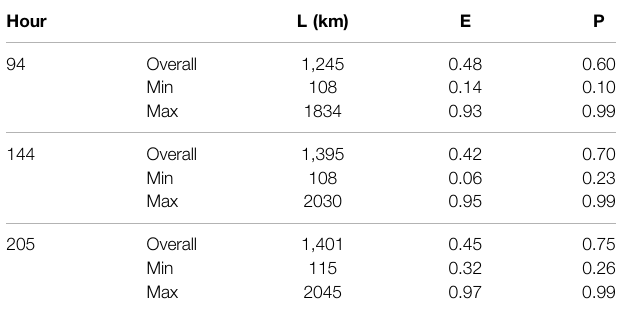
TABLE 1 | Characteristic geometric parameters for the three nine-spacecraft con fi gurations underconsiderationandtheminimum/maximumcharacteristic geometric parameters created from choosing any four of the nine spacecraft of each con fi guration.